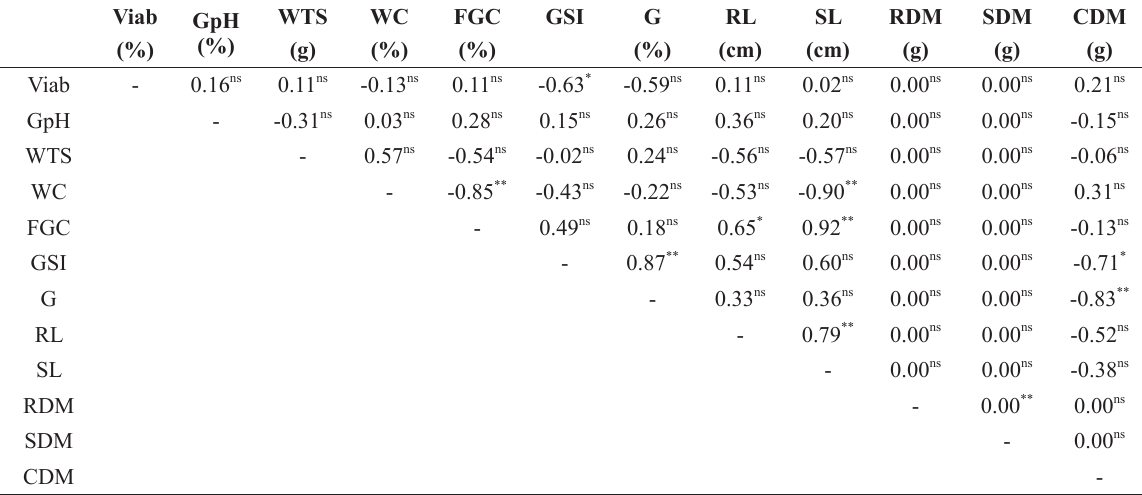
Pearson’s simple correlation coefficients (r) estimated between water content (WC), weight of one thousand seeds (WTS), first germination count (FGC), germination speed index (GSI), germination (G), root length (RL), shoot length (SL),